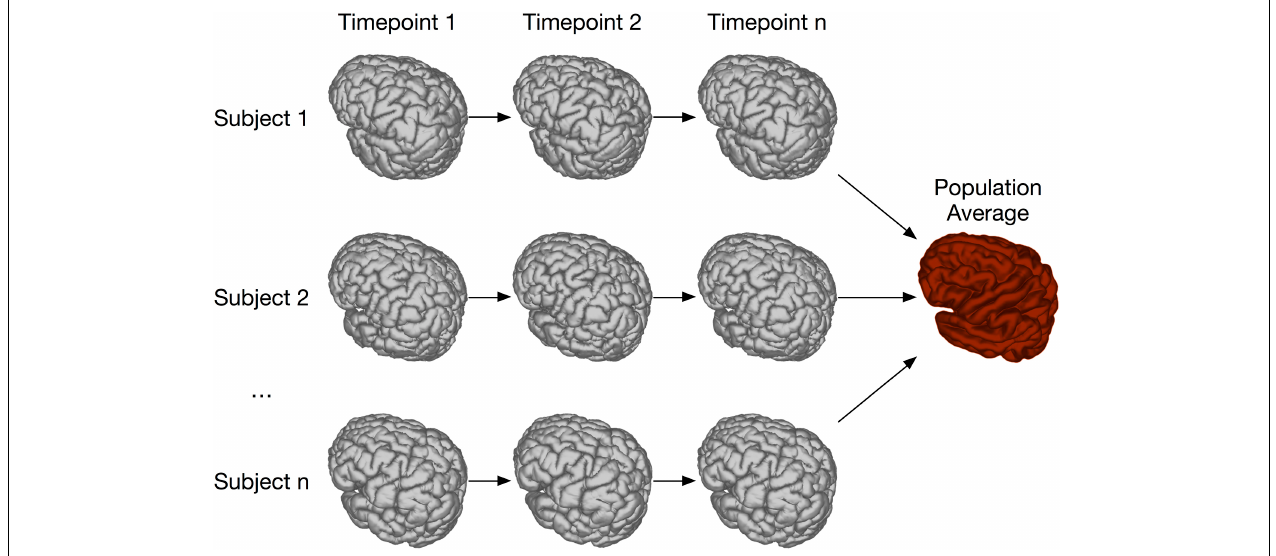
FIGURE 10 | Schematic of the registration chain pipeline. In this schematic, each subject is scanned at a series of timepoints. The arrows indicate that, within each subject, timepoint i is registered to timepoint i + 1.